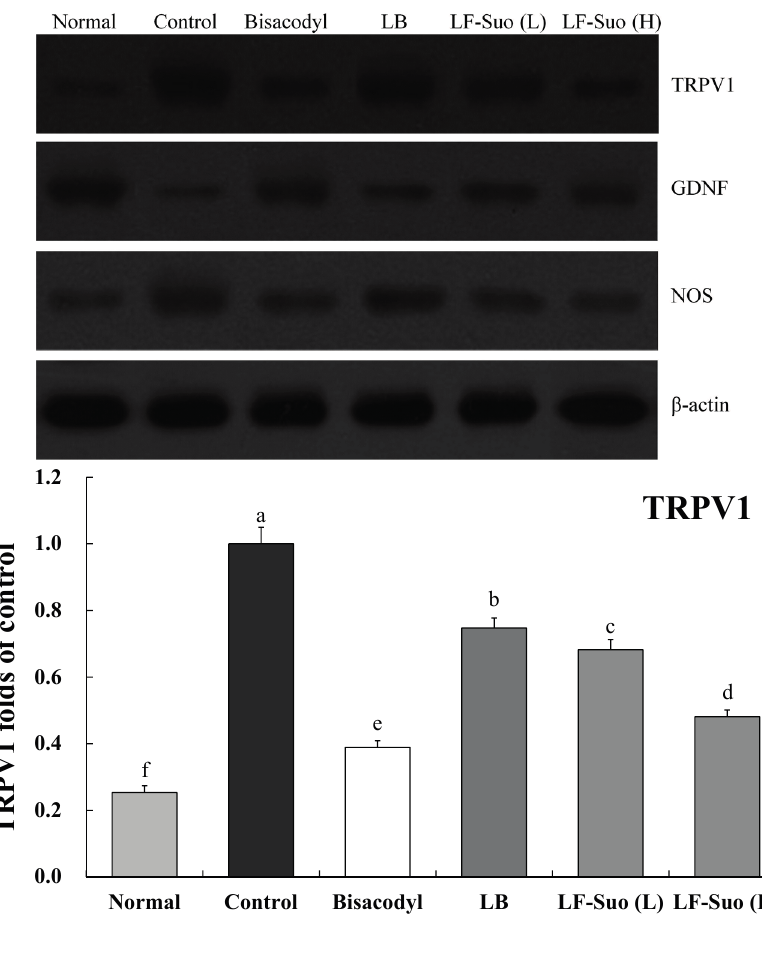
Figure 7. Effects of Lactobacillus fermentum Suo on the mRNA expression of TRPV1, GDNF and NOS in small intestine. n = 10 ICR mice in each group, bisacodyl: 100 mg/kg b.w.; LB: Lactobacillus bulgaricus (1.0 × 10 9 CFU/kg b.w.); LF-Suo (L): Lactobacillus fermentum Suo (0.1 × 10 9 CFU/kg b.w.); LF-Suo (H): Lactobacillus fermentum Suo (1.0 × 10 9 CFU/kg b.w.); a–f Mean values with different letters over the bars are significantly different ( p < 0.05) according to Duncan’s multiple range